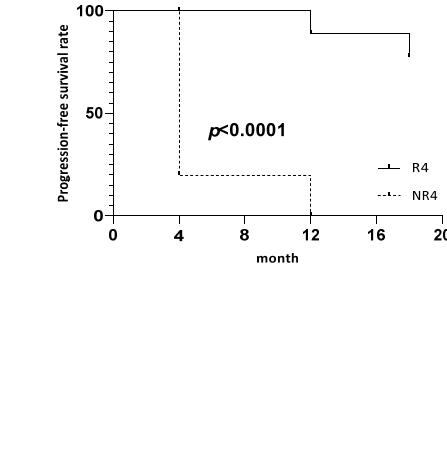
Figure 2. Survival curves: ( A ) Overall survival and progression-free survival of early responder. (R4: responder at 4 months post treatment, NR4: nonresponder at 4 months post treatment). ( B ) Overall survival and progression-free survival of patients depending on CTC at baseline. ( C ) Overall survival and progression-free survival of patients depending on CTC at day 21 (D21). 3.3. Variation in the Number of CTCs between Baseline and D21 and the Survival Rate Of the 11 DCF patients who had a blood sample collected at day 21, 4 patients (33%) (patients #2, #3, #5, and #14) had a positive variation of CTCs (an increase in CTCs be- tween baseline and day 21) and 2 had clusters at day 21 (patient #3, early responder and patient #14, early nonresponder). Two patients (16.7%) (patients #1 and #15) had a nega- tive variation (decreased CTCs between baseline and day 21). There was no significant association between a positive variation in the CTC number and CTC phenotype or cluster. Despite the absence of a significant difference in the OS and PFS between patients with a positive variation and negative variation in CTCs ( p = 0.48 and 0.75, respectively) (Figure 3), we observed a clear tendency in patients with a positive variation to have a lower OS.